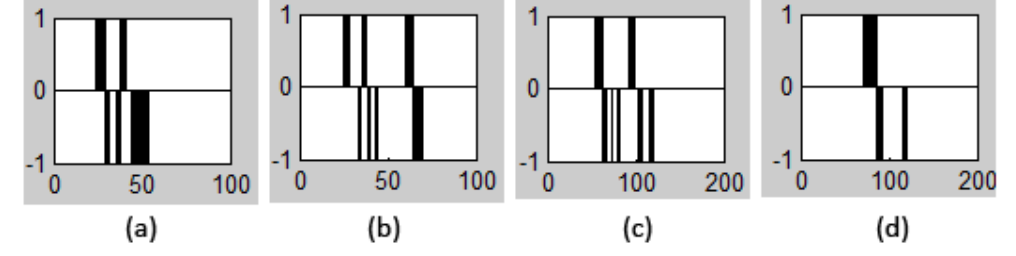
Figure 5. Derivative of projection profiles in after applying Sign